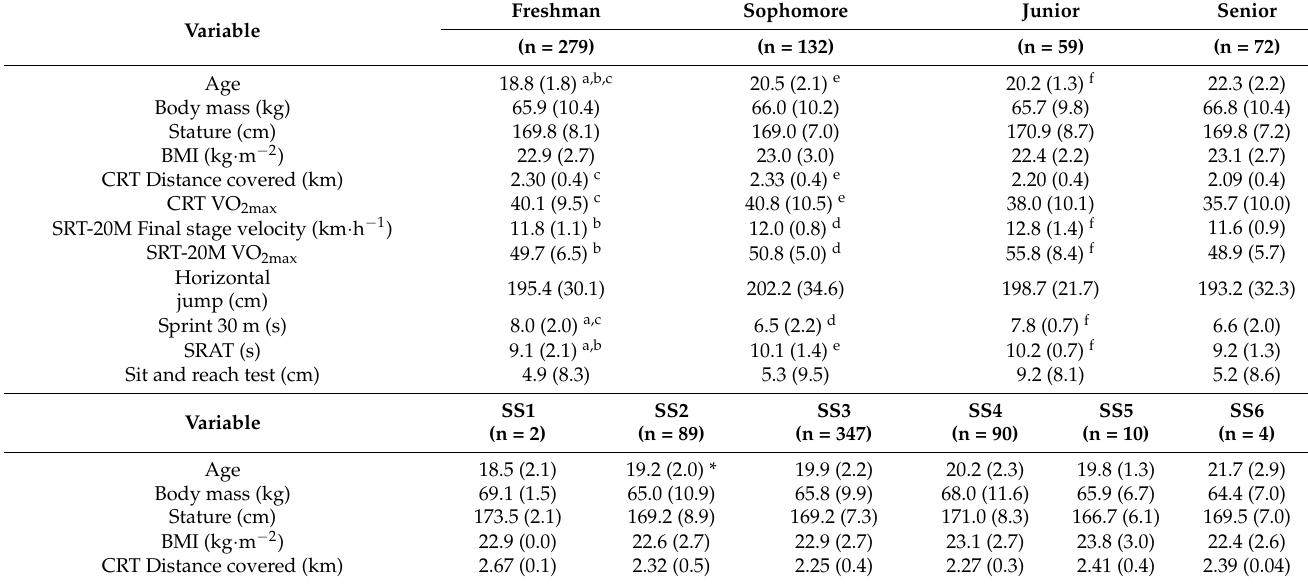
Figure 1. Horizontal half violin plots of the physical fitness variables by sex. This figure shows the distribution of the different physical fitness variables measured in female (pink) and male (blue) majors. Black circles represent the mean, while dark grey diamonds the raw data. CRT: Cooper Run Test; SRAT: Shuttle Run Agility Test; SRT-20M: Shuttle Run Test. * Significant difference p < 0.05. The characteristics of the population by academic year and by socioeconomic strata are shown in Table 2. Table 2. Characteristics of the participants grouped by academic year and socioeconomic strata.